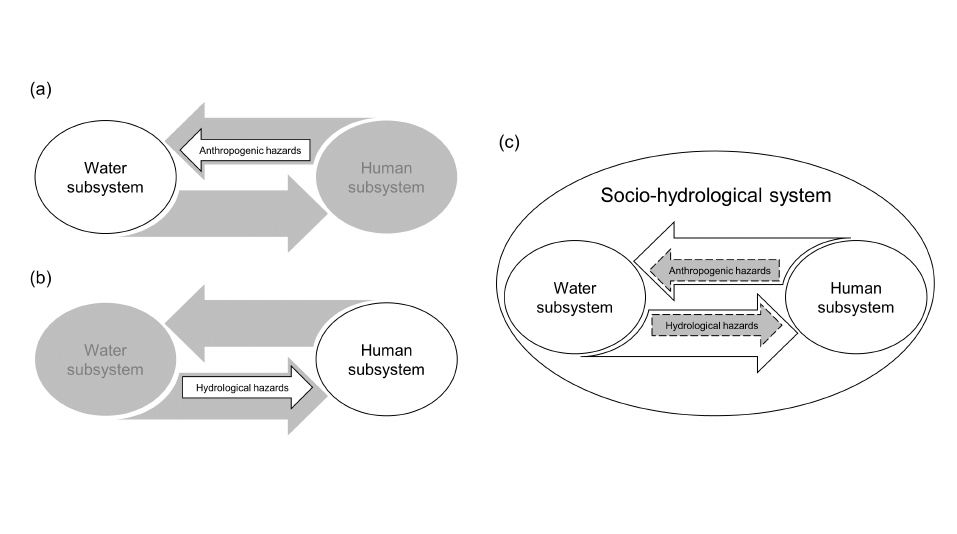
Figure 2. Schematic diagram of three human–water coupling types, each foregrounding different aspects of the socio-hydrological sys- tem. (a) Water subsystem with anthropogenic hazards, where the human subsystem, water impacts on human subsystem, or other forms of human impacts on the water subsystem are not the main focus. (b) Human subsystem with hydrological hazards, where, similarly to the water subsystem, human impacts on water subsystem or other forms of water impact on the water subsystem are not emphasised. (c) Socio- hydrological system with water and human subsystems and anthropogenic and hydrological hazards as two of many forms of human–water interactions. Table 1. A comparison of three types of human–water couplings and resilience